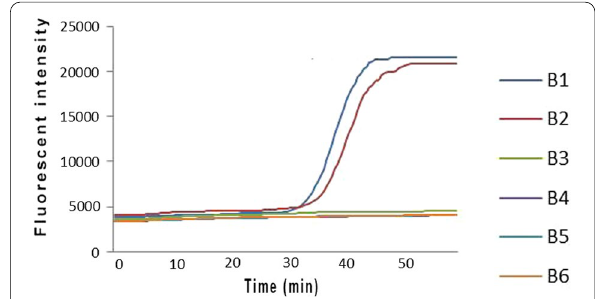
Fig. 3 The sensitivity of real‑time fluorescence LAMP